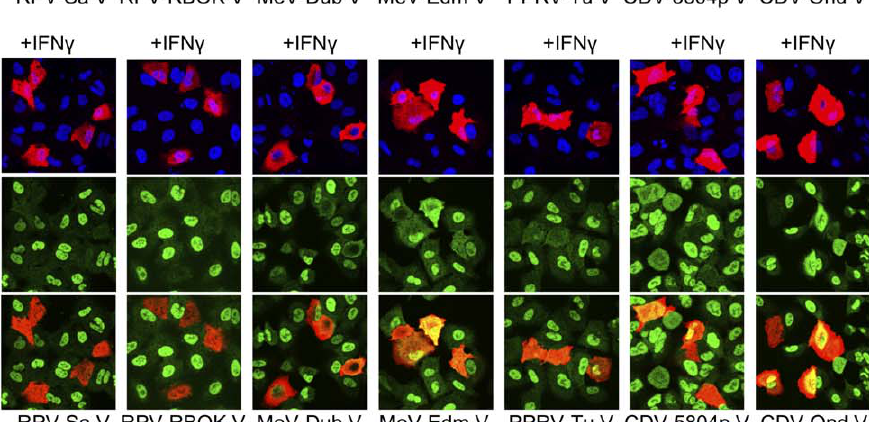
Figure 3. Morbillivirus V proteins show better ability to block IFN a -induced STAT1 and STAT2 phosphorylation than INF c -induced STAT1 phosphorylation. A549 cells were transfected with 1 m g of empty vector or plasmid driving the expression of the indicated protein. Twenty hours post-transfection, cells were mock treated or treated with (a),(b) 1000 IU/ml of IFN a or (c) 1000 IU/ml of IFN c for 30 minutes, fixed with PFA followed by methanol and stained with monoclonal anti-V5 tag and (a), (c) anti-phospho-STAT1 (STAT1P) or (b) anti-STAT2 as in ‘‘Material and methods’’.. Representative confocal images from three independent experiments are shown.